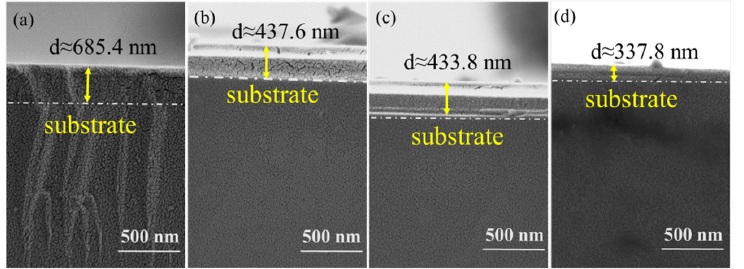
Figure 6. Cross ‐ sectional SEM images of Ta 2 O 5 coatings prepared under different sputtering gases. ( a ) 40Ar, ( b ) 36Ar–4N 2 , ( c ) 34Ar–6N 2 , ( d ) 32Ar–8N 2. Table 2. Surface hardness and elastic modulus of Ta 2 O 5 coatings were prepared under different sputtering gas conditions.